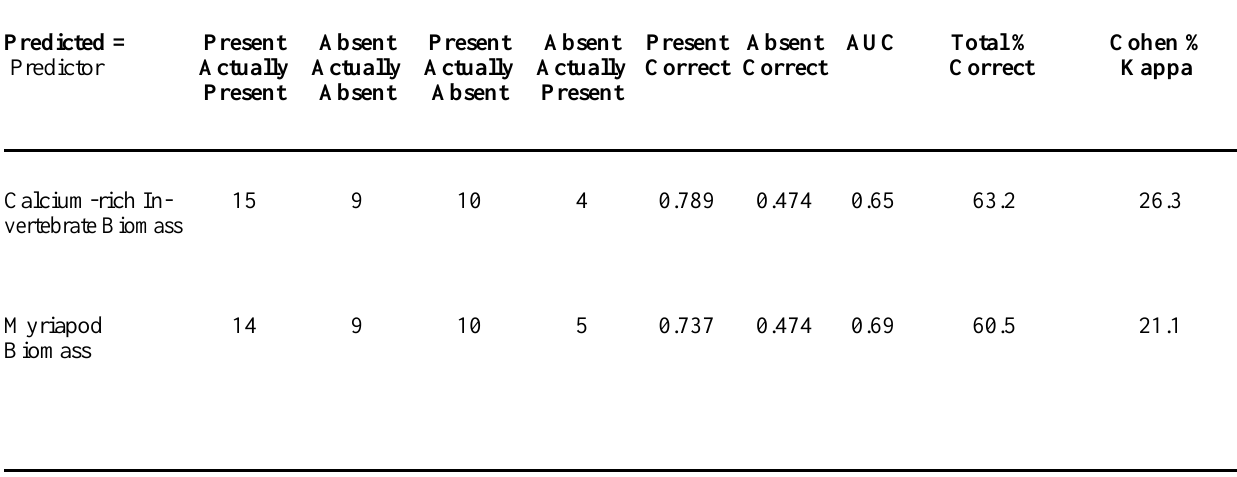
Table 2. Performance of logistic regression models at predicting presence of a breeding Wood Thrush at a study site, given either the biomass of calcium-rich prey, without slugs, or the biomass of myriapods. The measures of performance are based on the confusion matrices tabulating actual and predicted presences (Guisan and Zimmermann 2000). Cohen’s Kappa measures the improvement in number of correct classification to the above the number expected to be correctly classified by chance (Cohen 1960). Area under the curve values (AUC) were computed from receiver operating characteristic curves